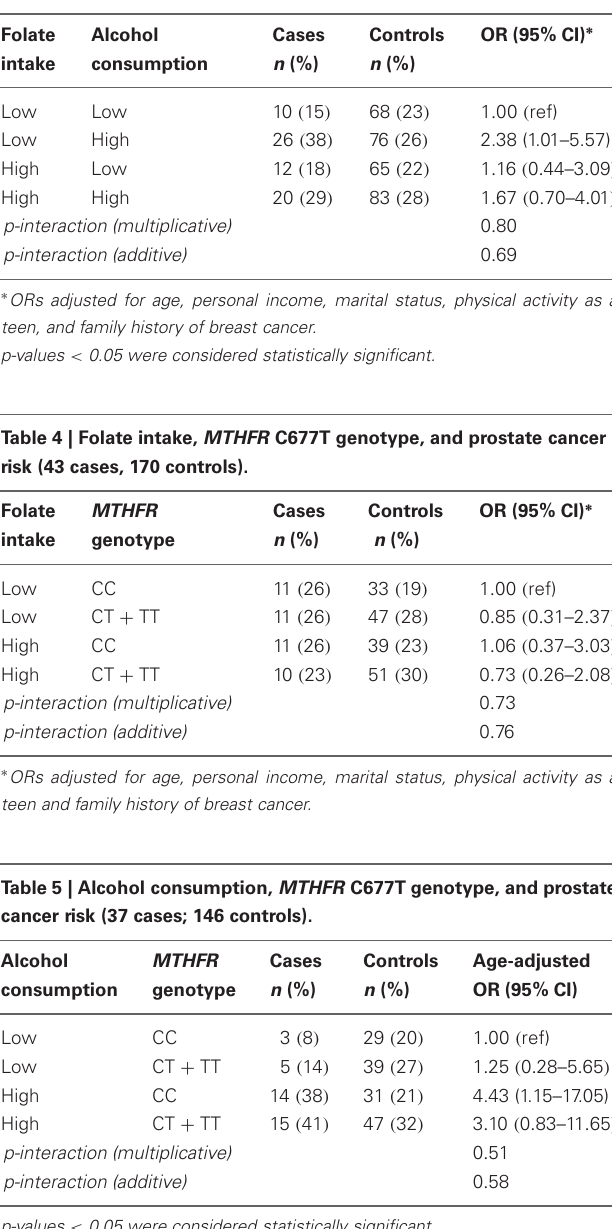
Table 3 | Folate intake, alcohol consumption, and prostate cancer risk (68 cases; 292 controls).